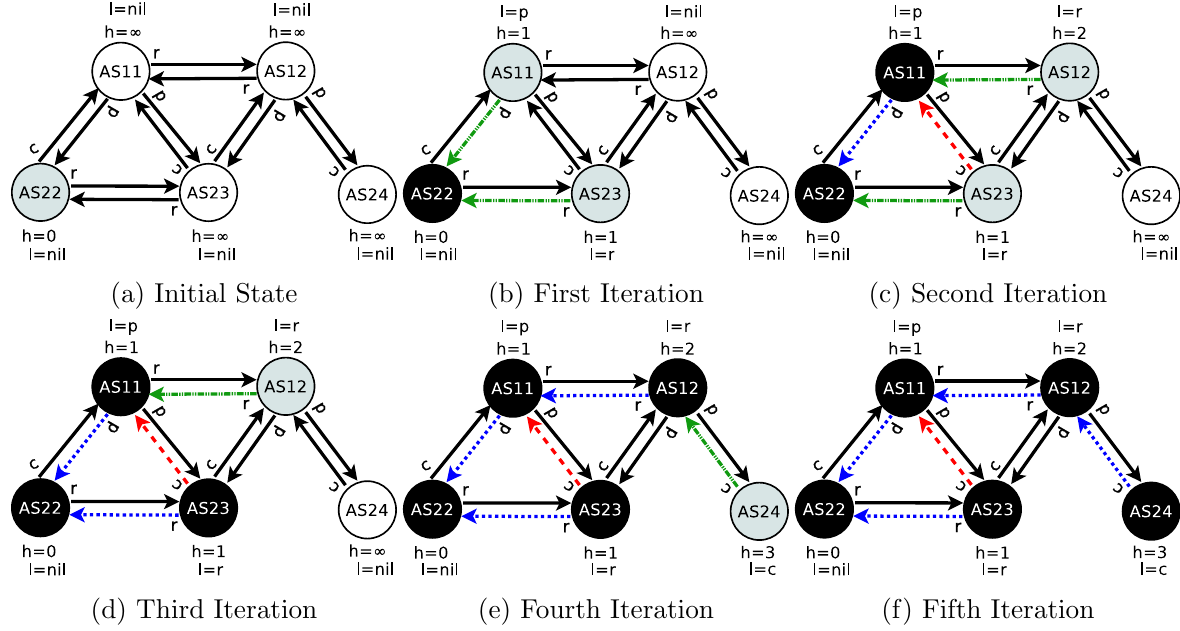
Figure 3: An illustrative overview of the Policy-Preferred AS Path Enumeration Algorithm. The algorithm gradually builds policy-preferred paths toward the destination vertex AS 22 from all vertices in backwards. White vertices are undiscovered vertices, gray vertices are discovered but not fully explored vertices and black vertices are fully explored vertices. Green (dashed-dotted) edges are candidate preferable edges, blue (dotted) edges are established, preferred edges toward the destination vertex and red (dashed) edges are ineffective relax- ations. Latest join labels and join hop-distances are shown with l and h ,